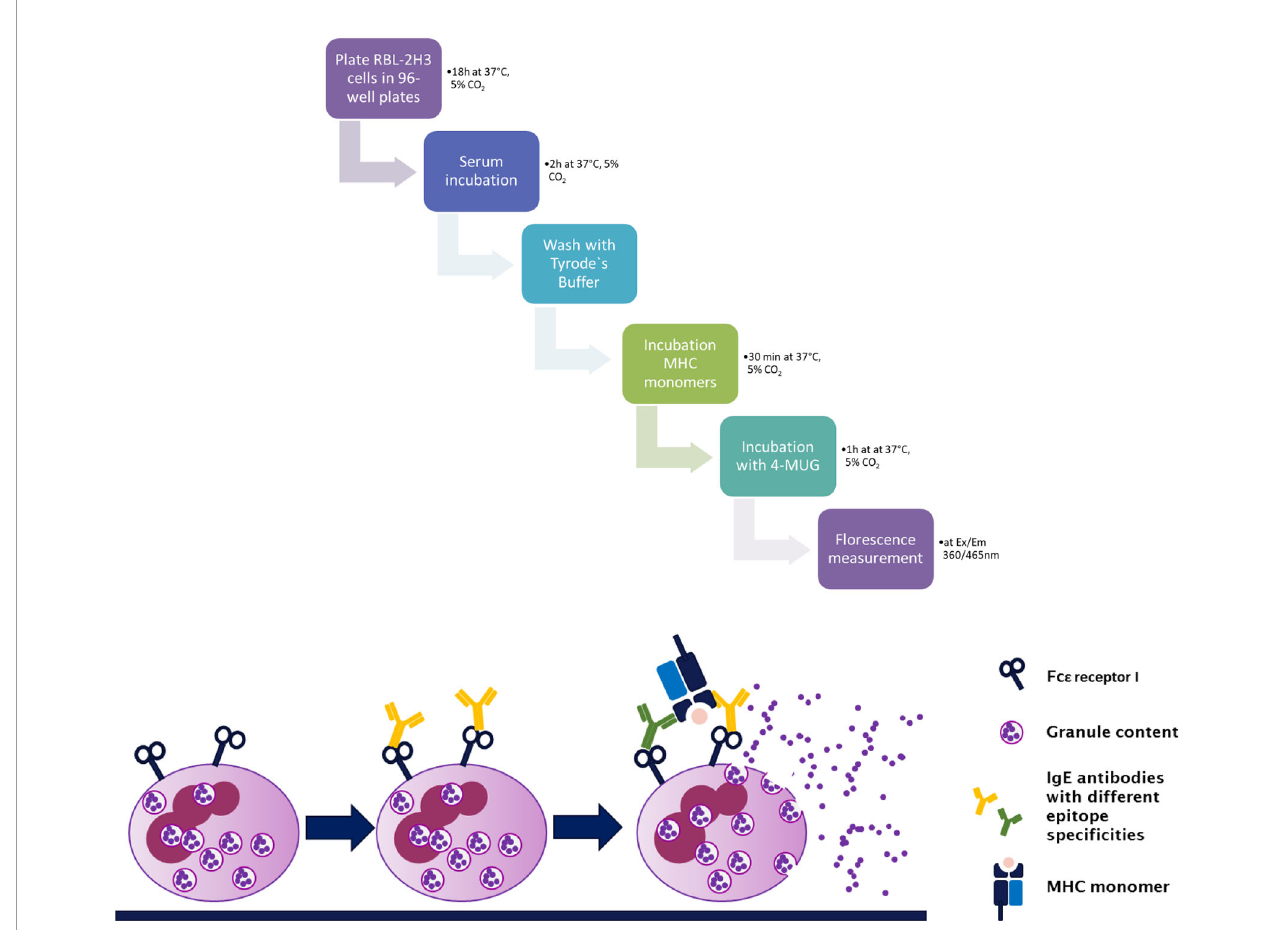
FIGURE 2 | Step by step procedure and schematic representation of the rat basophil leukemia cell degranulation assay. Cells from the rat basophilic leukemia strain (RBL-2H3) are incubated with murine serum that shall be tested for the presence of functional MHC-speci fi c IgE. MHC-speci fi c IgE binds to its high af fi nity receptor Fc ϵ RI. This is followed by incubation with a murine MHC monomer (class I or class II). Crosslinking of bound IgE antibodies via speci fi c antigen, in this case MHC, leads to degranulation of the RBL-2H3 cells, releasing b -hexasominidase, amongst other granule content. The detection substrate 4-MUG is cleaved to 4-MU via this enzyme leading to a fl uorescence signal at Ex/Em 360/465